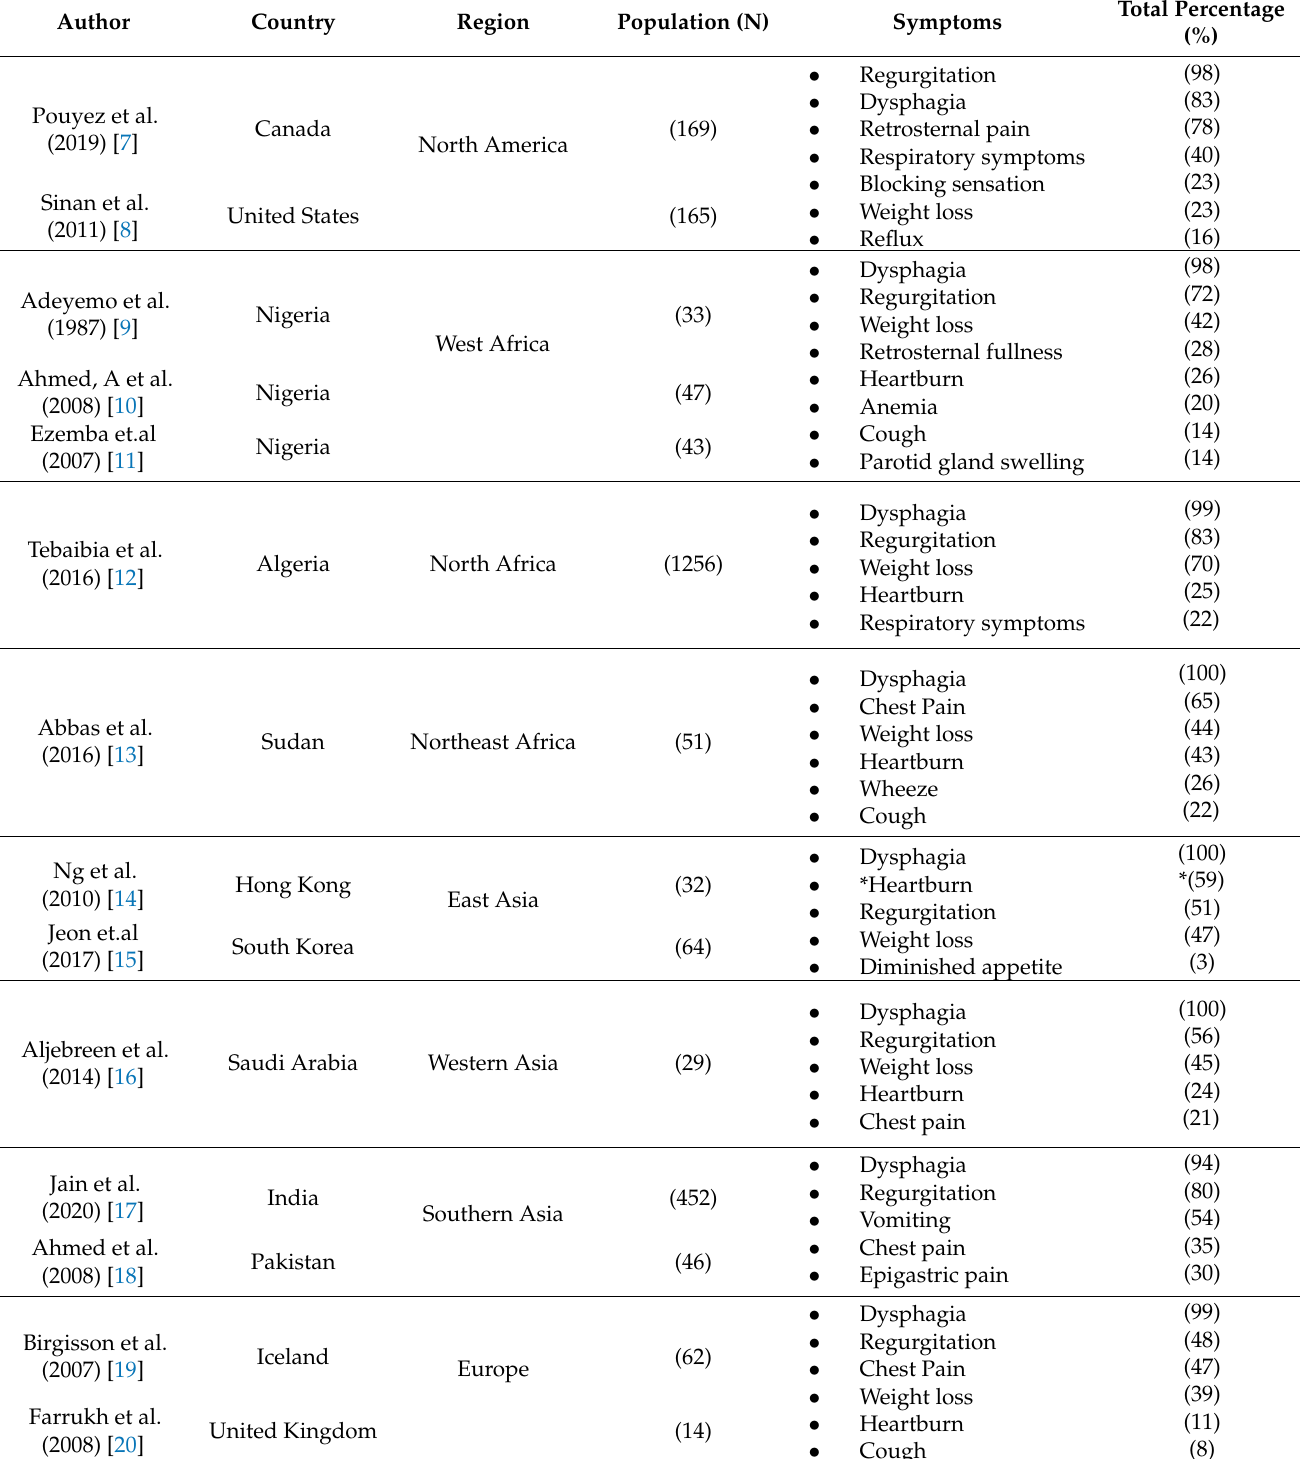
Table 1. Summarized table of 14 studies and most prevalent symptoms of achalasia in each